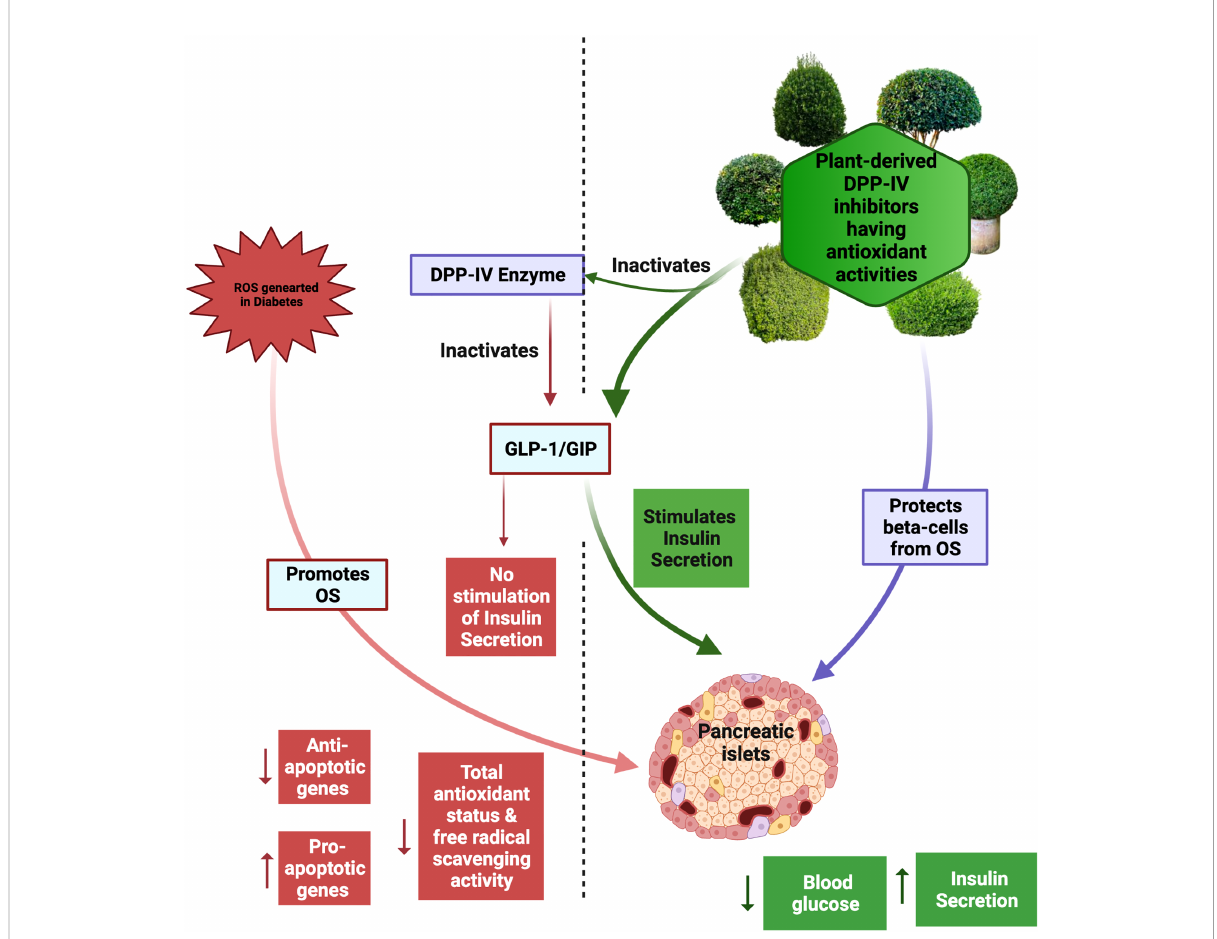
FIGURE 4 Role of dipeptidyl peptidase inhibitors with antioxidant properties in protecting pancreatic b -cells and treating diabetes. GLP-1, glucagon-like peptide-1; GIP, glucose-dependent intestinal polypeptide; OS, oxidative